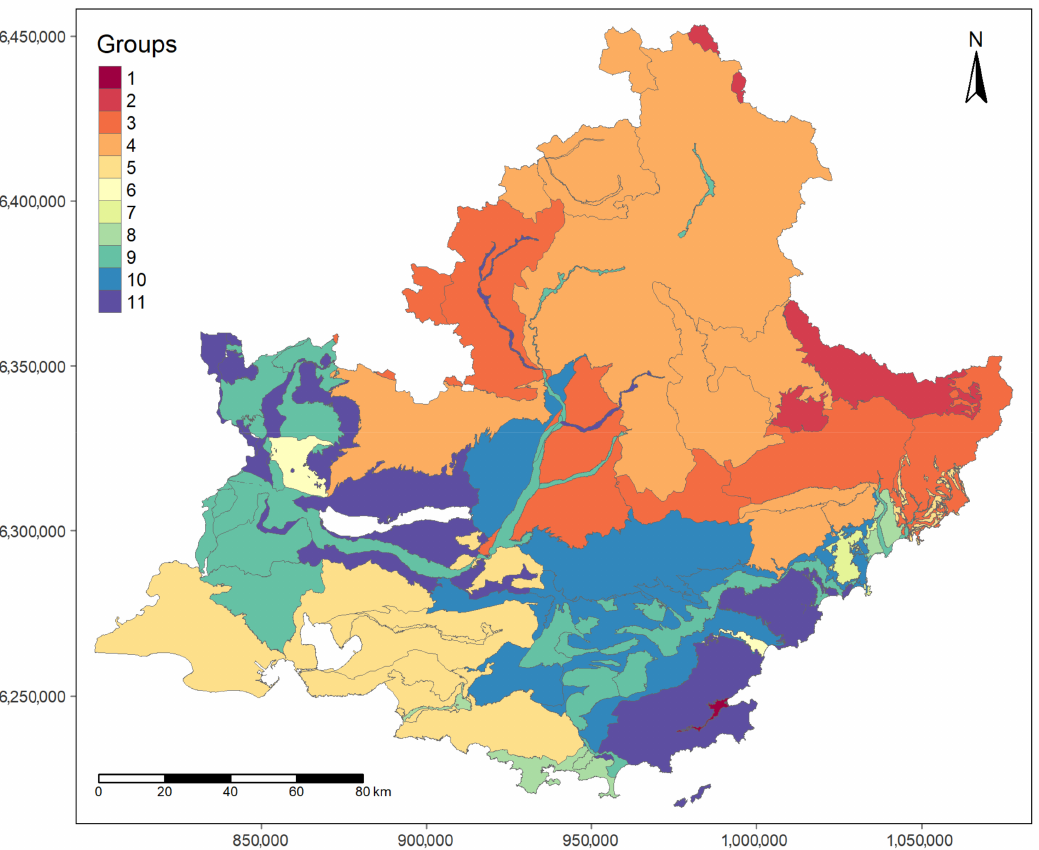
Figure 6. Spatial distribution of groundwater bodies (GWB) clusters resulted from agglomerative hierarchical clustering (AHC).